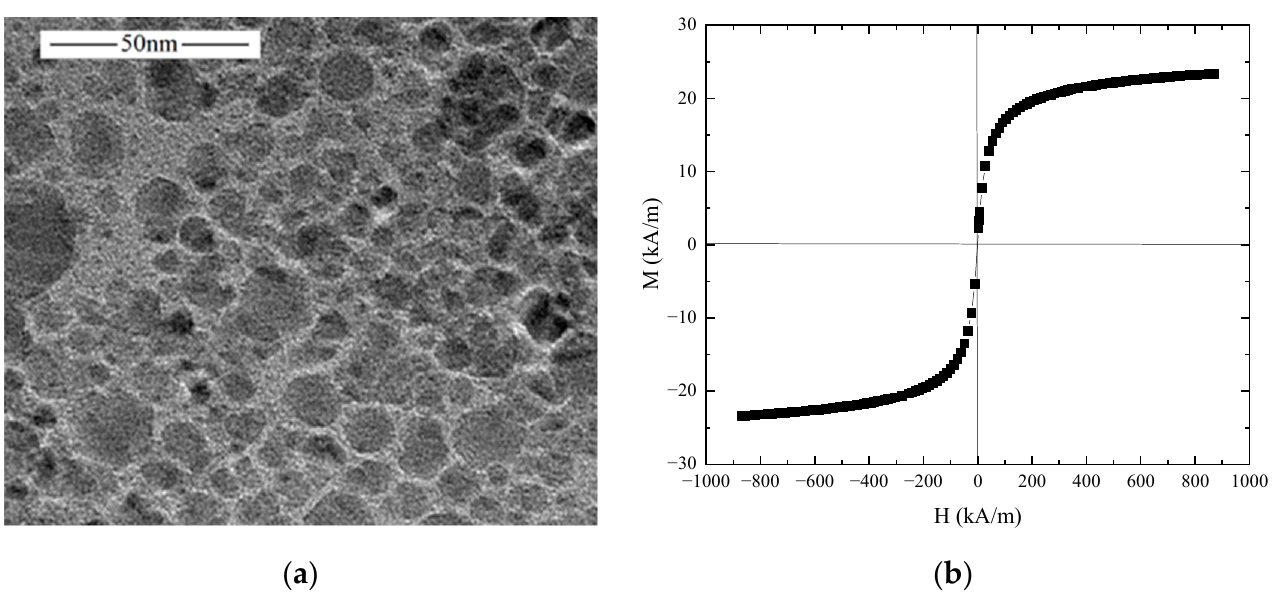
Figure 1. ( a ) TEM image of nanoparticles; ( b ) VSM magnetization curve for the magnetic fluid. Table 1. Parameters of the examined magnetic fluid.